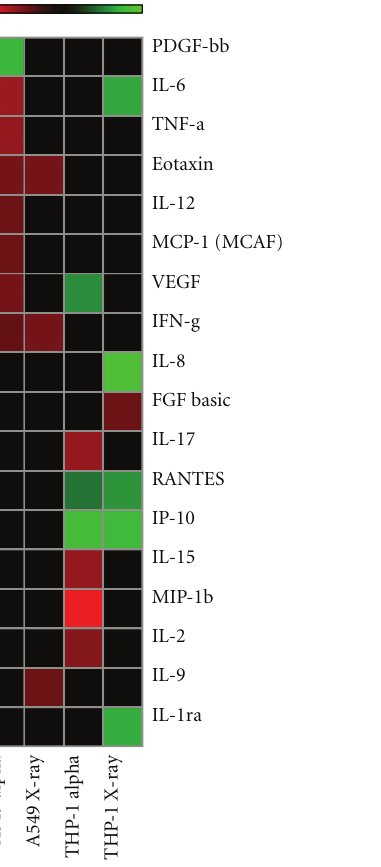
Figure 5: Heat map displaying cytokine fold changes for all cell lines assessed. Upregulation is represented with green shading and downregulation with red. Expression varies from − 2.5 to 2.5.